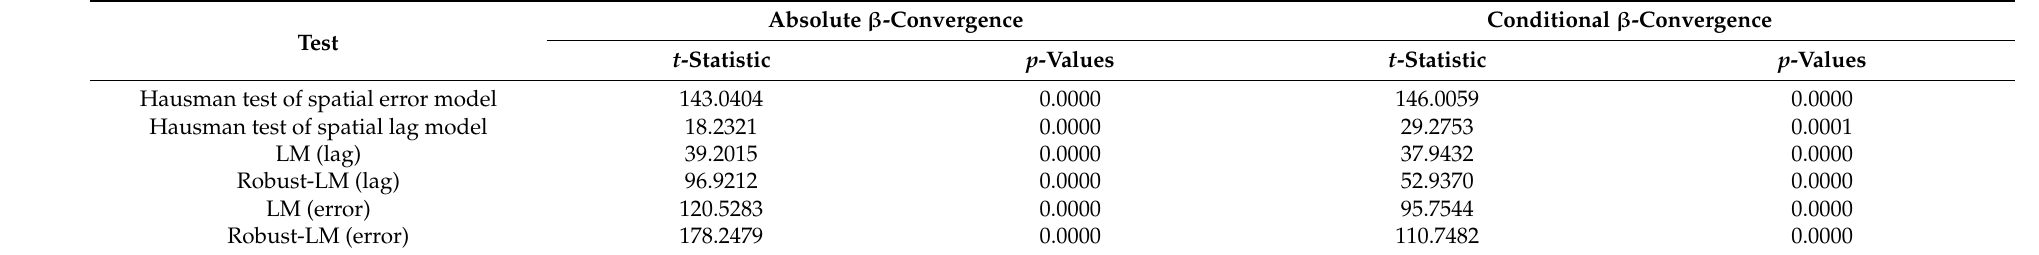
Table 4. ULUE spatial correlation